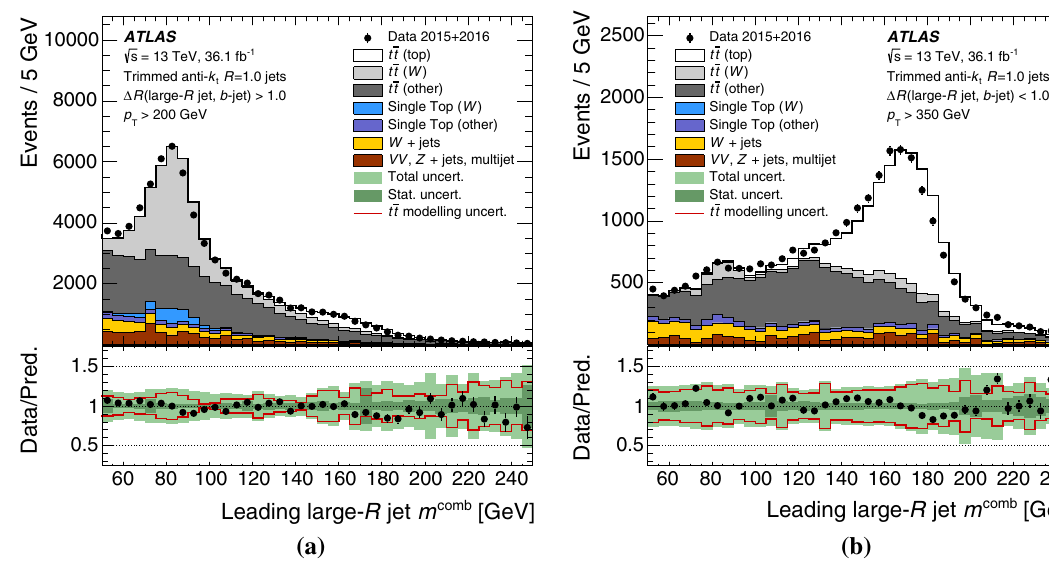
| η | < 2 . 47, excluding the calorimeter transition region from